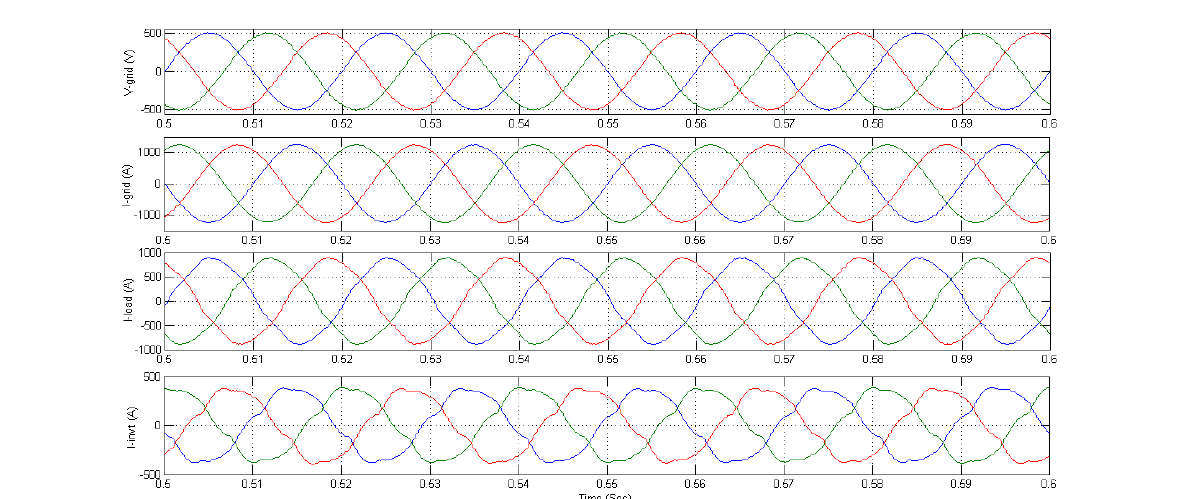
Figure 6b. Harmonics free operation